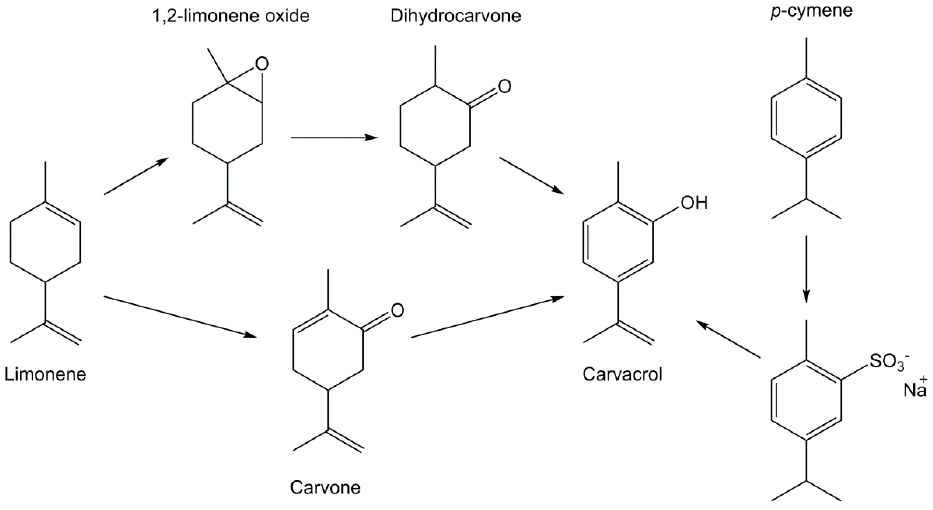
Figure 10. Structures of eugenol and ferulic